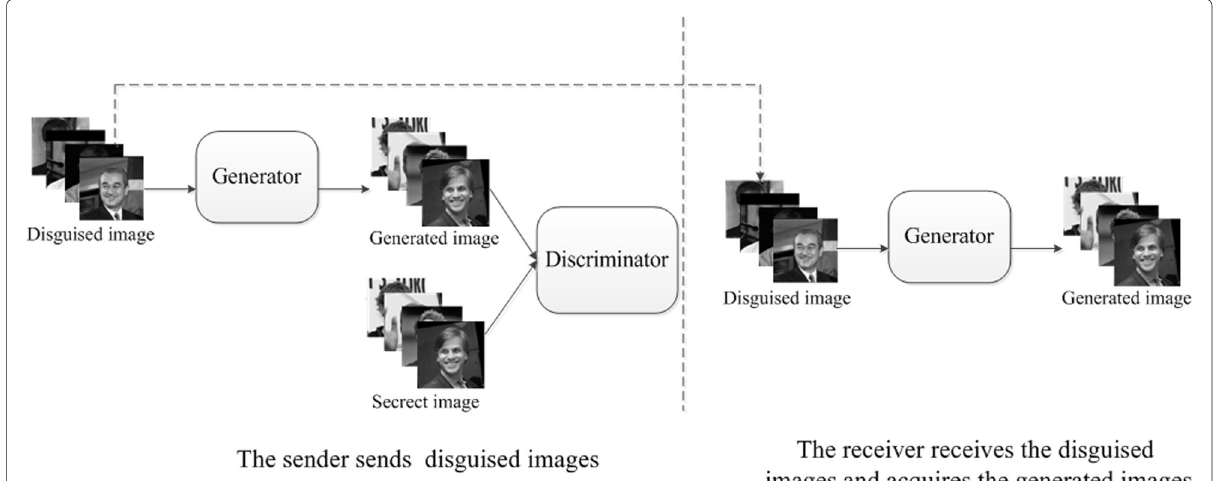
Fig. 4 The process of information